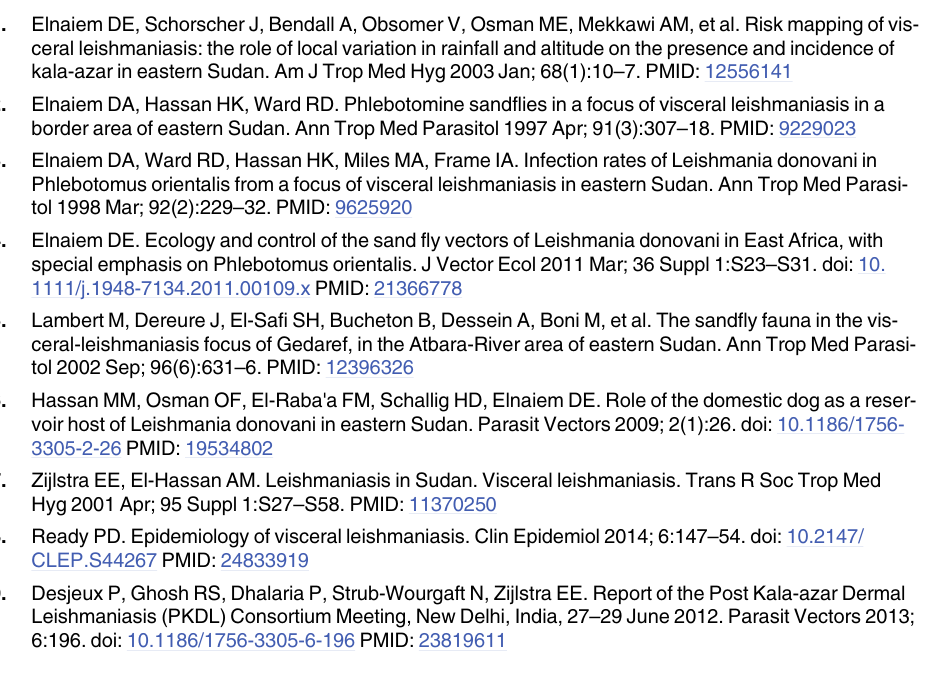
S2 Table. Multivariate models of individual and household determinants for visceral leish- maniasis (with village as a random